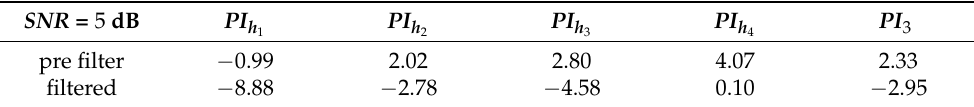
Table 3. Values [dB] of the performance indexes defined by (12): case of SNR = 5 [dB].